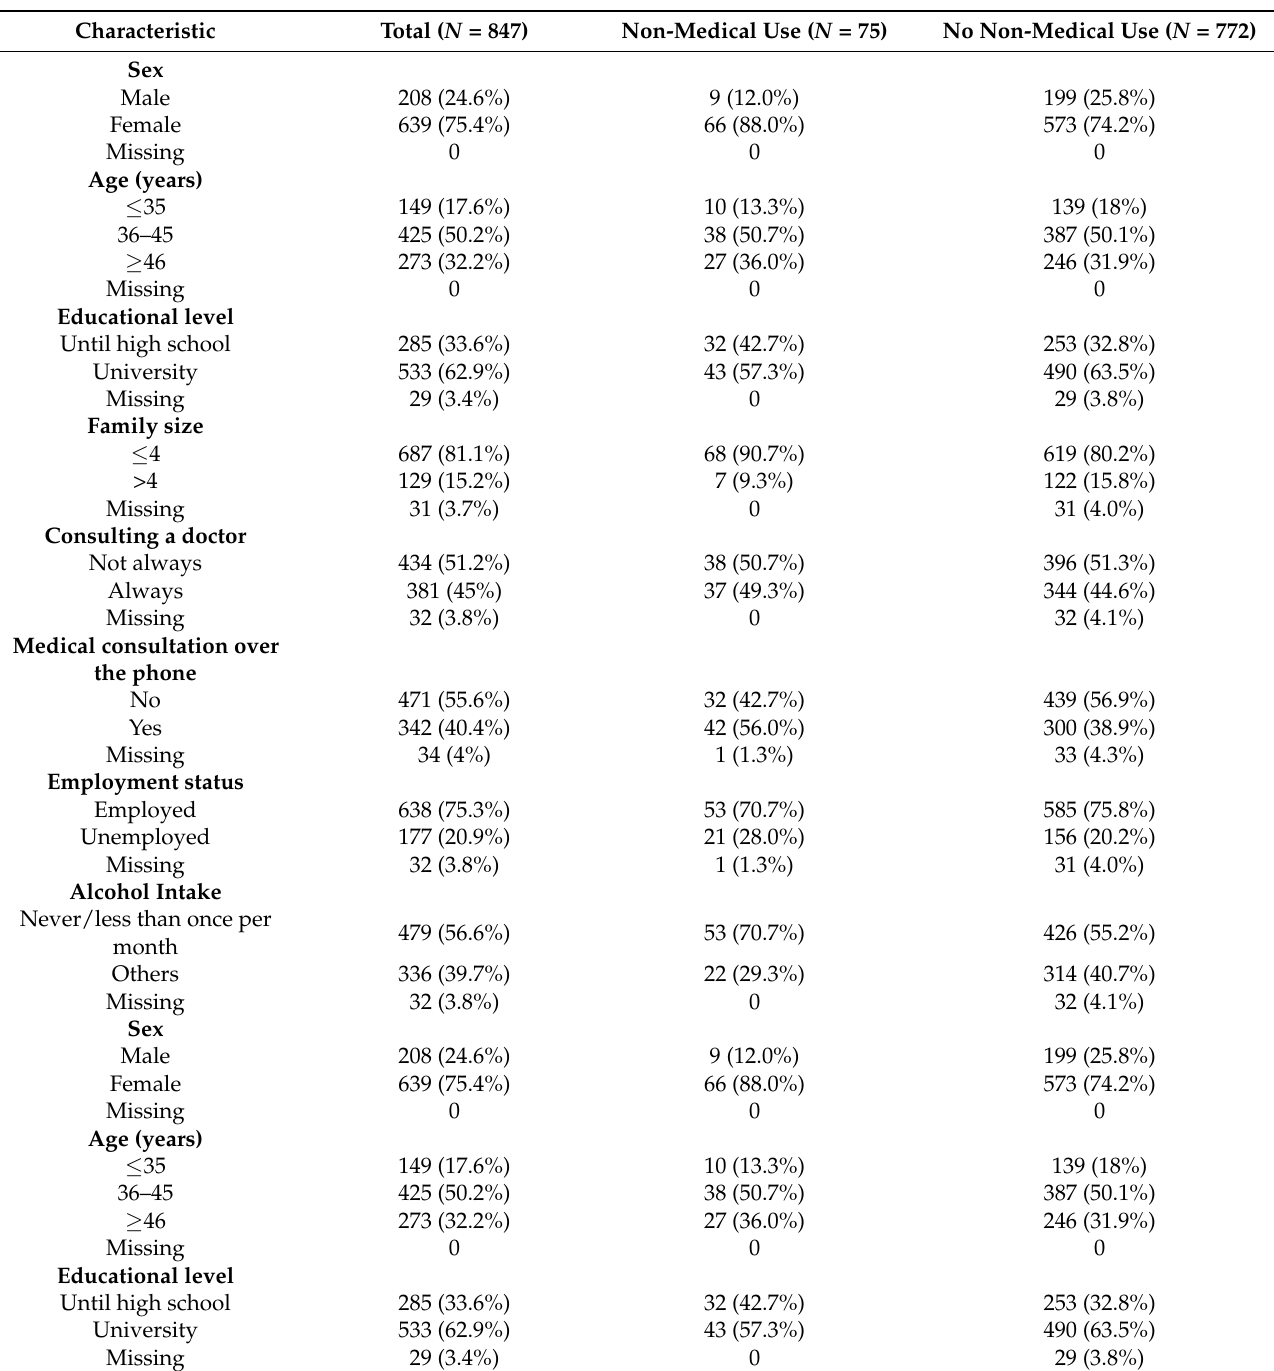
Table 1. Sociodemographic characteristics of the study